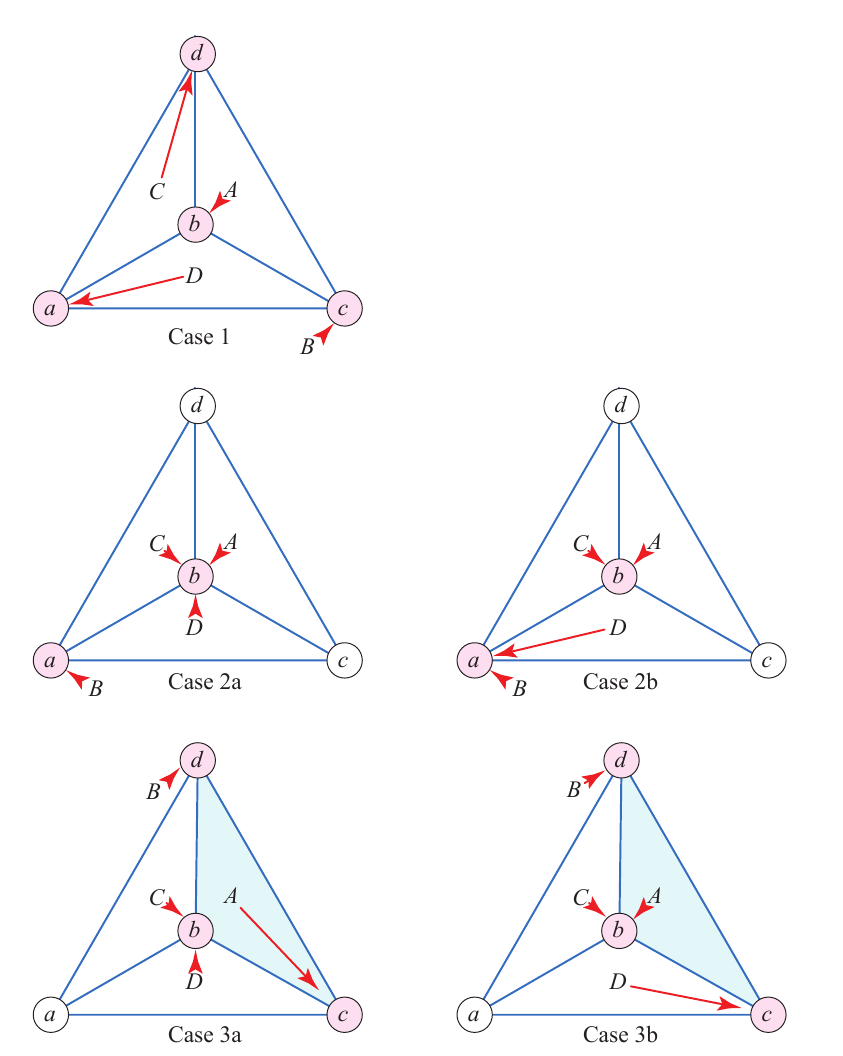
Figure 15. Failures. Case 1: at 4 vertices. Case 2: at 2 vertices. Case 3: at 3